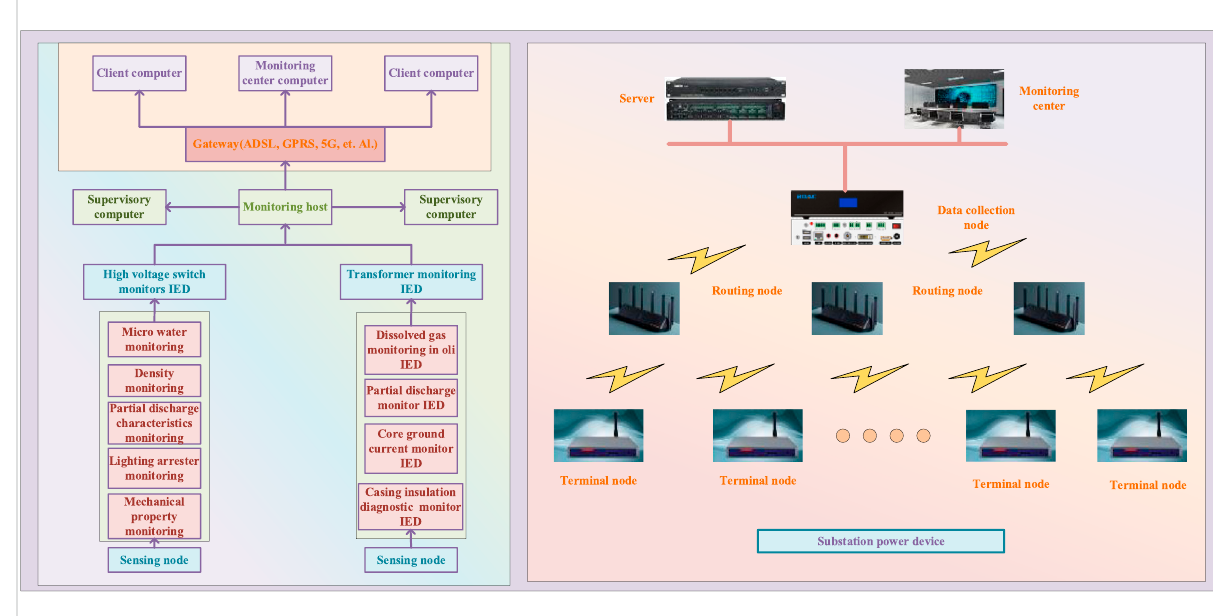
FIGURE 1 Overall layout diagram and hardware system structure of online monitoring system of smart